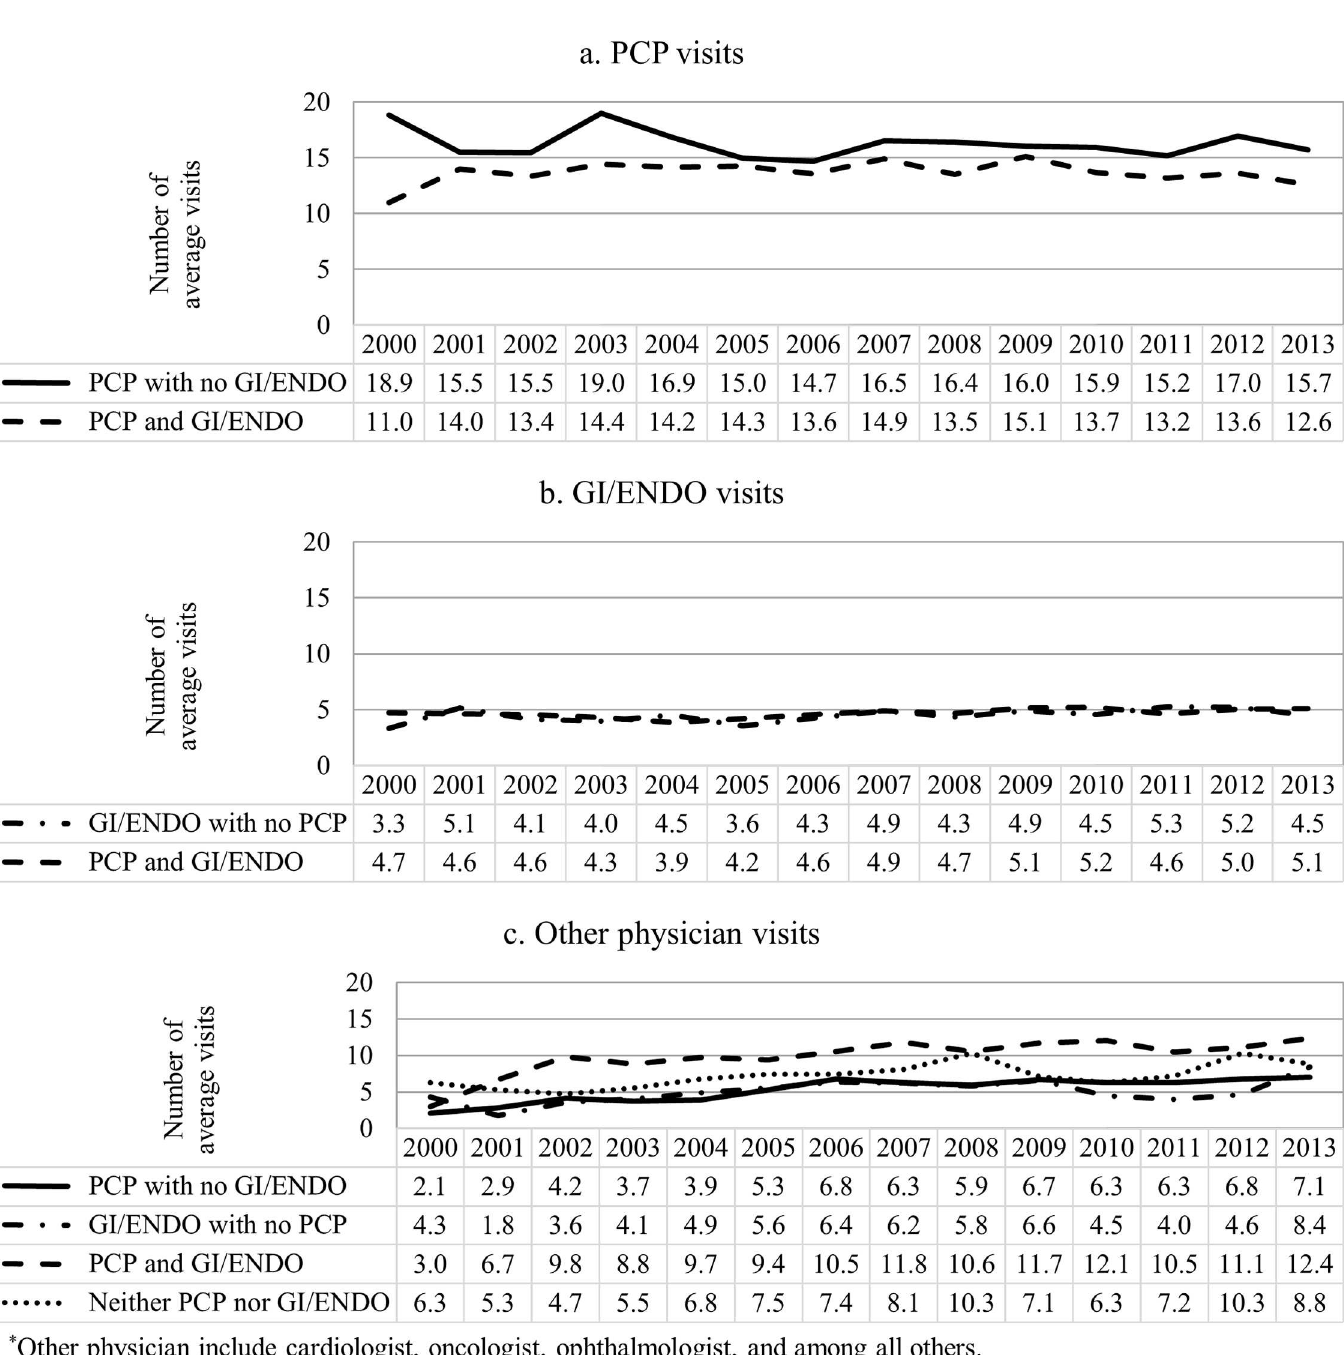
Fig 5. Average number of annual visits to physician specialties among dually diagnosed patients, by physician mix